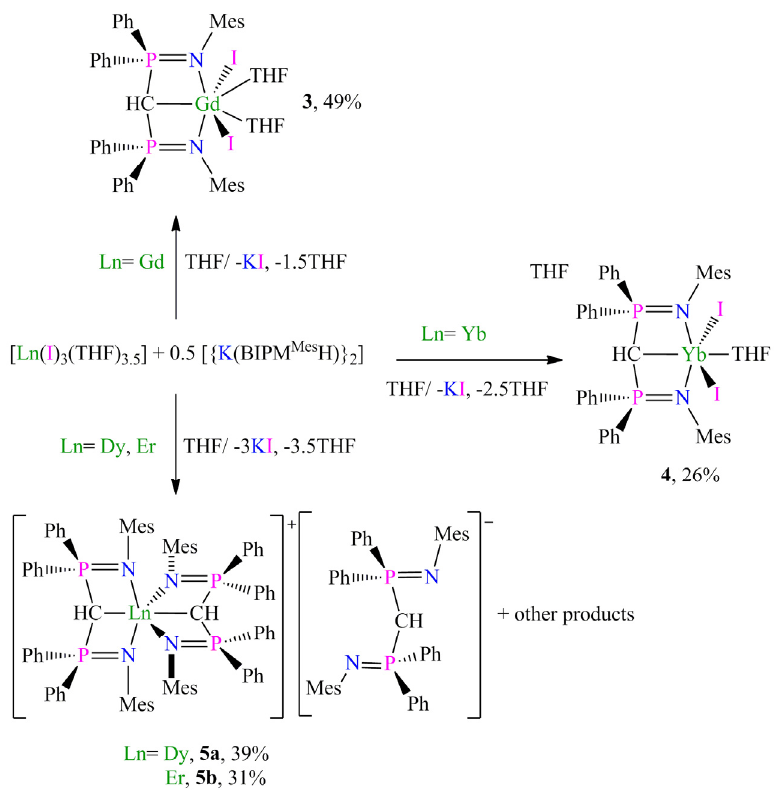
H with selected atom labelling. Displacement 7 8